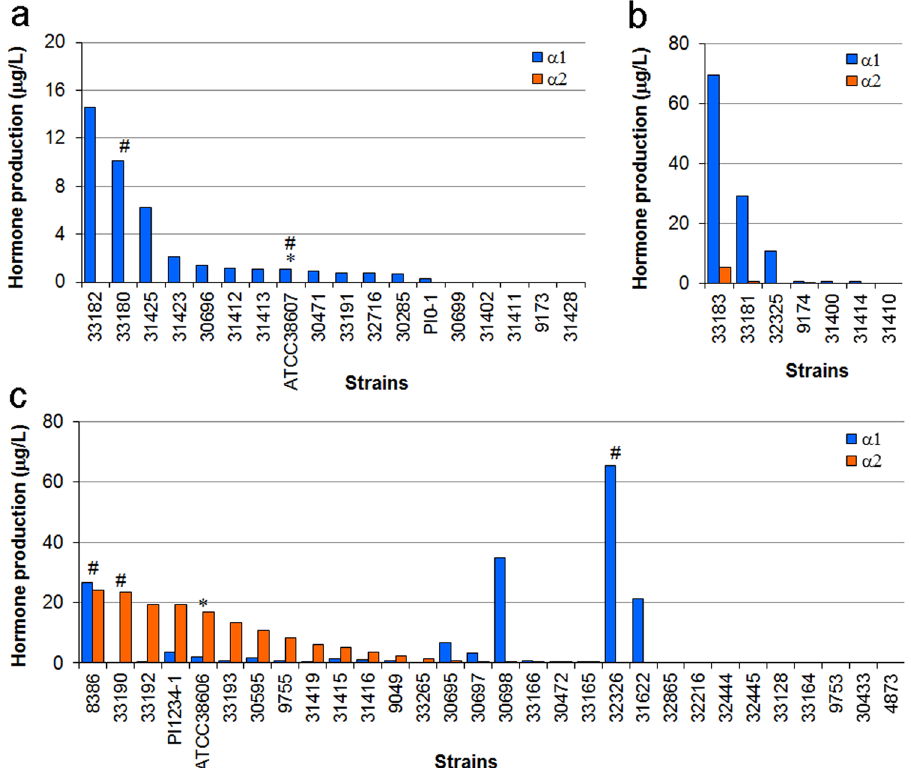
Figure 3. Difference in mating hormone productivity between mating types. The mating hormone production by the A1 ( a ), A1,A2 ( b ) and A2 ( c ) mating-type strains is shown in descending amounts of α 1 ( a , b ) and α 2 ( c ). The numerals without alphabetic characters indicate the NBRC strain numbers. The asterisks ( * ) indicate the standard strains previously used for the first hormone isolation 6 and as the mating type testers. The hash signs (#) indicate the strains used to demonstrate the time-dependent production of the hormones (see the next section). Each datum was obtained by a single experiment.